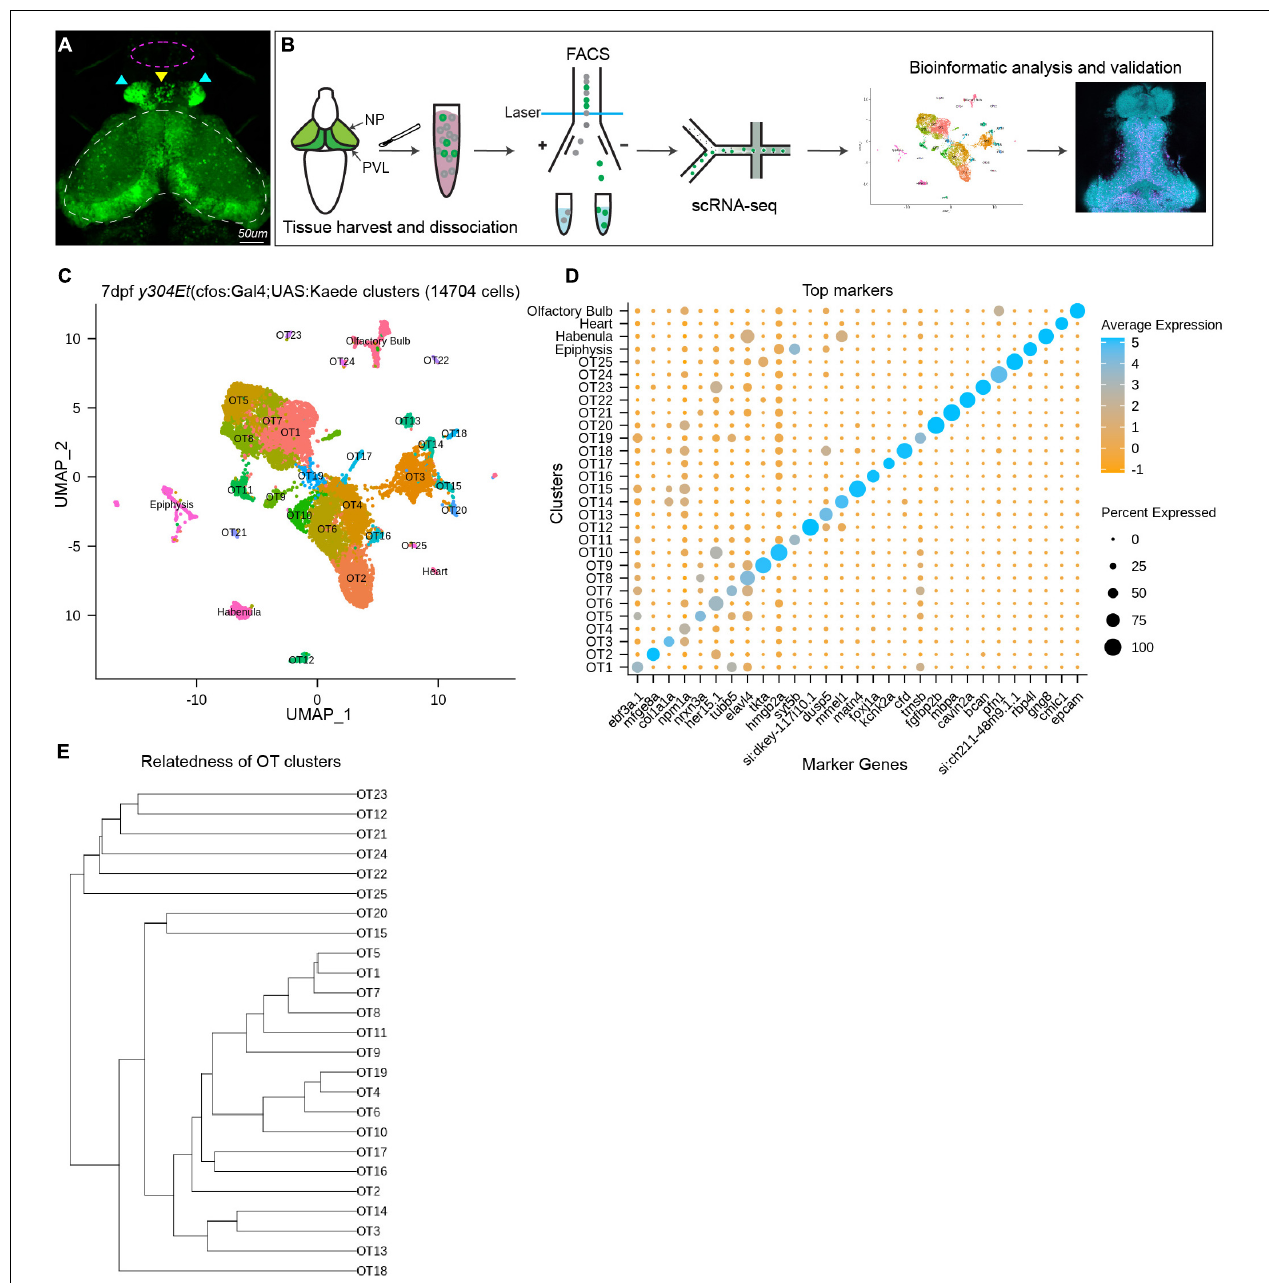
FIGURE 1 | Analysis of scRNA-seq data reveals 25 distinct populations within the larval zebrafish optic tectum. (A) 7 dpf representative image of the y304Et (cfos: Gal4 ;UAS: Kaede ) enhancer trap line used to obtain tectal cells. Optic tectum (white dashes), habenula (cyan arrows), epiphysis (yellow arrow), and olfactory system (magenta dashes) are indicated. The heart is not shown. (B) Experimental workflow for the collection and isolation of tectal cells. Heads from 7 dpf Kaede + larvae were collected and enzymatically dissociated, followed by FACS to isolate fluorescent cells. After quality control, 14,704 single-cell libraries obtained by the 10X Genomics Chromium platform were used for downstream analysis. PCA and graph-based clustering were utilized to sort cells into clusters and identify candidate marker genes. Bioinformatic validation and spatial mapping was completed via fluorescent HCR RNA-FISH. (C) Uniform manifold approximation and projection (UMAP) showing cell populations identified via scRNA-seq analysis of 14,704 Kaede + cells. Each point represents a single cell colored according to cluster identity as determined by unbiased graph-based clustering using the Louvain algorithm with multilevel refinement. UMAP embedding was used for visualization purposes only and not to define the clusters. The resulting two-dimensional spatial arrangement of clusters is a product of genetic similarity, as similar clusters are represented as closer together. (D) Candidate marker genes (columns) for each cluster (rows) were nominated by differential expression analysis wherein candidate genes must: (1) be expressed in at least 50% of cells within that cluster, and (2) show specificity to the cluster compared to all other cells by exhibiting ≥ 1 log2 fold-change in expression with at least 25% difference in gene presence. (E) Phylogram showing cluster relatedness based upon variable features defined by SCTransform and calculated within PCA